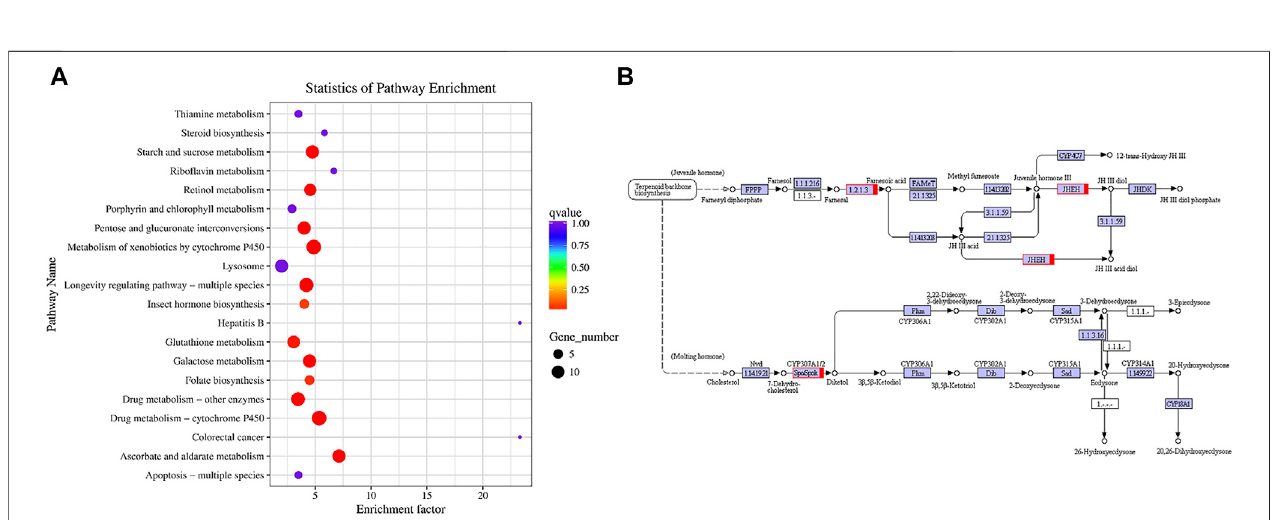
FIGURE 4 | DEG pathway enrichment analysis. (A) Top 20 pathway enrichment analysis of differentially expressed genes. (B) Insect hormone biosynthesis pathway. Pathways were identi fi ed based on number of enriched genes, p -value, and rich factor.